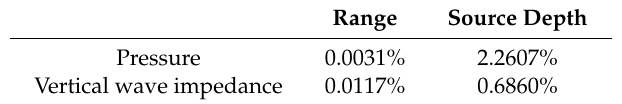
Figure 7. Localization results for the measured vector as the pressure (black line) and the vertical wave impedance (red line). ( a ) Range estimation result with pressure as the measured vector; ( b ) source depth estimation result with pressure as the measured vector; ( c ) range estimation result with vertical wave impedance as the measured vector; ( d ) source depth estimation result with vertical wave impedance as the measured. Table 6. MAPE of localization results in the frequency domain of 50 Hz–150 Hz.